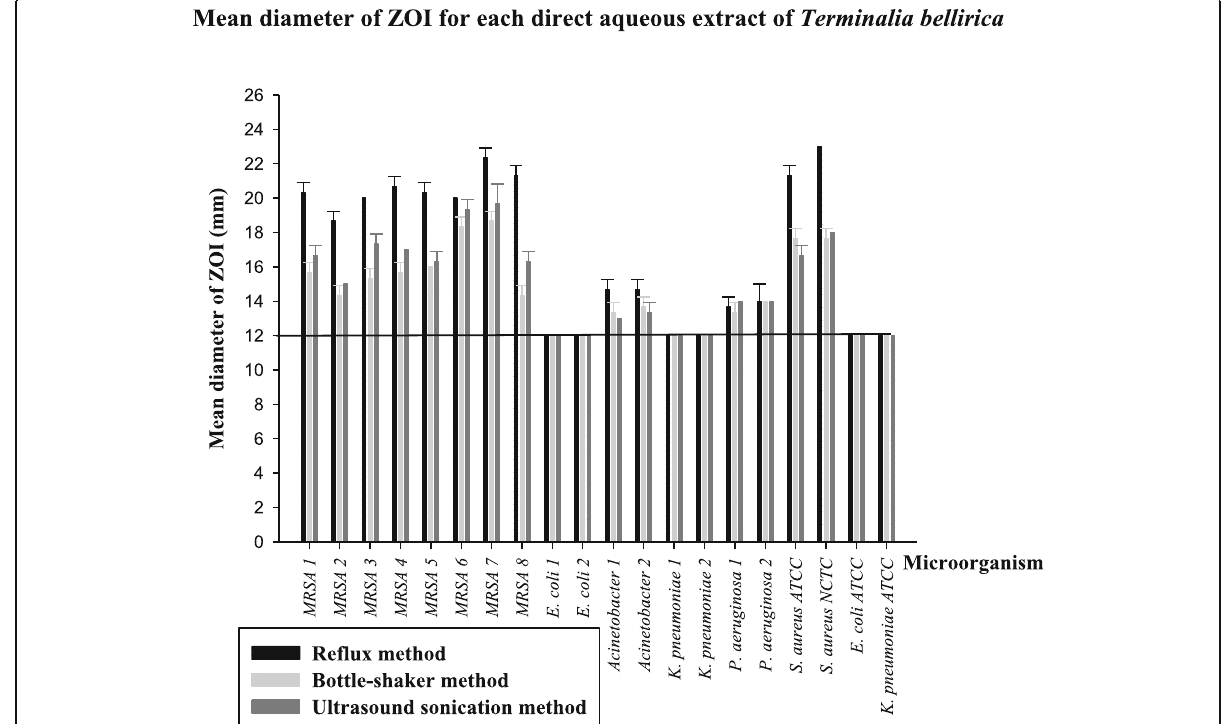
Fig. 2 Mean diameter of zones of inhibition (ZOI) for direct aqueous extracts (10 mg/mL) of Terminalia bellirica prepared from reflux method, bottle-shaker method and ultrasound sonication